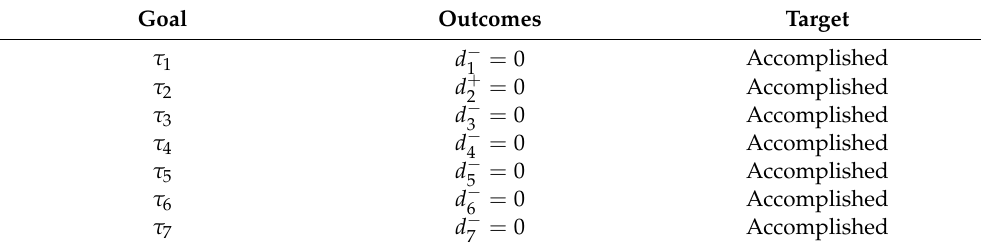
Table 5. Target achievement.